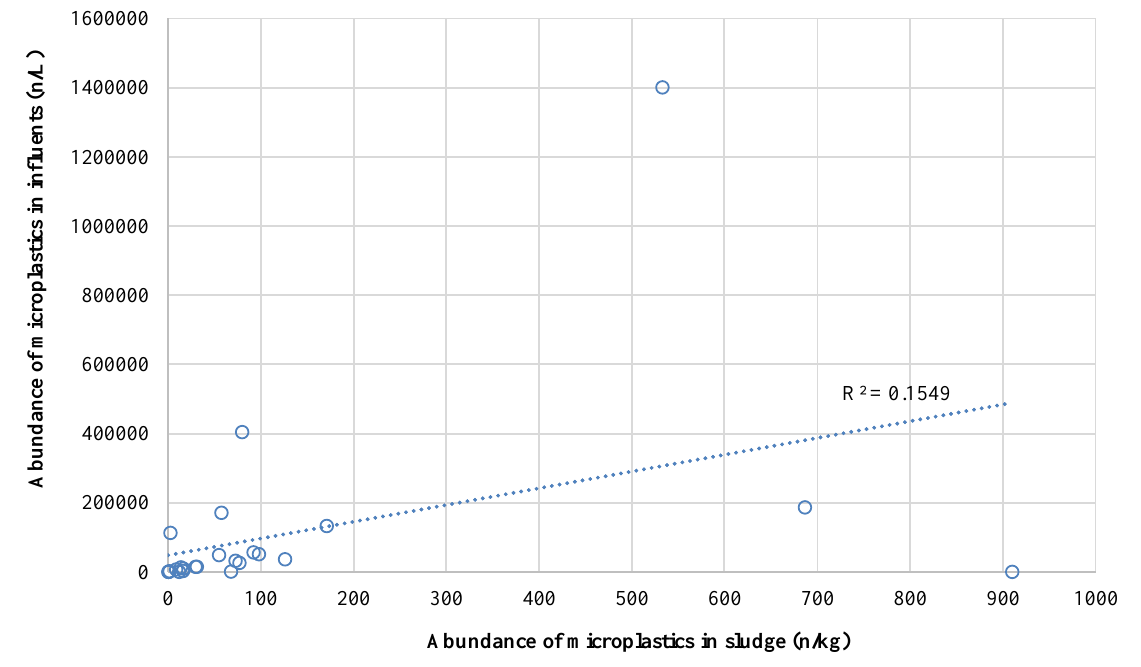
Figure 5. Relationship between the abundance of microplastics in influents and that in